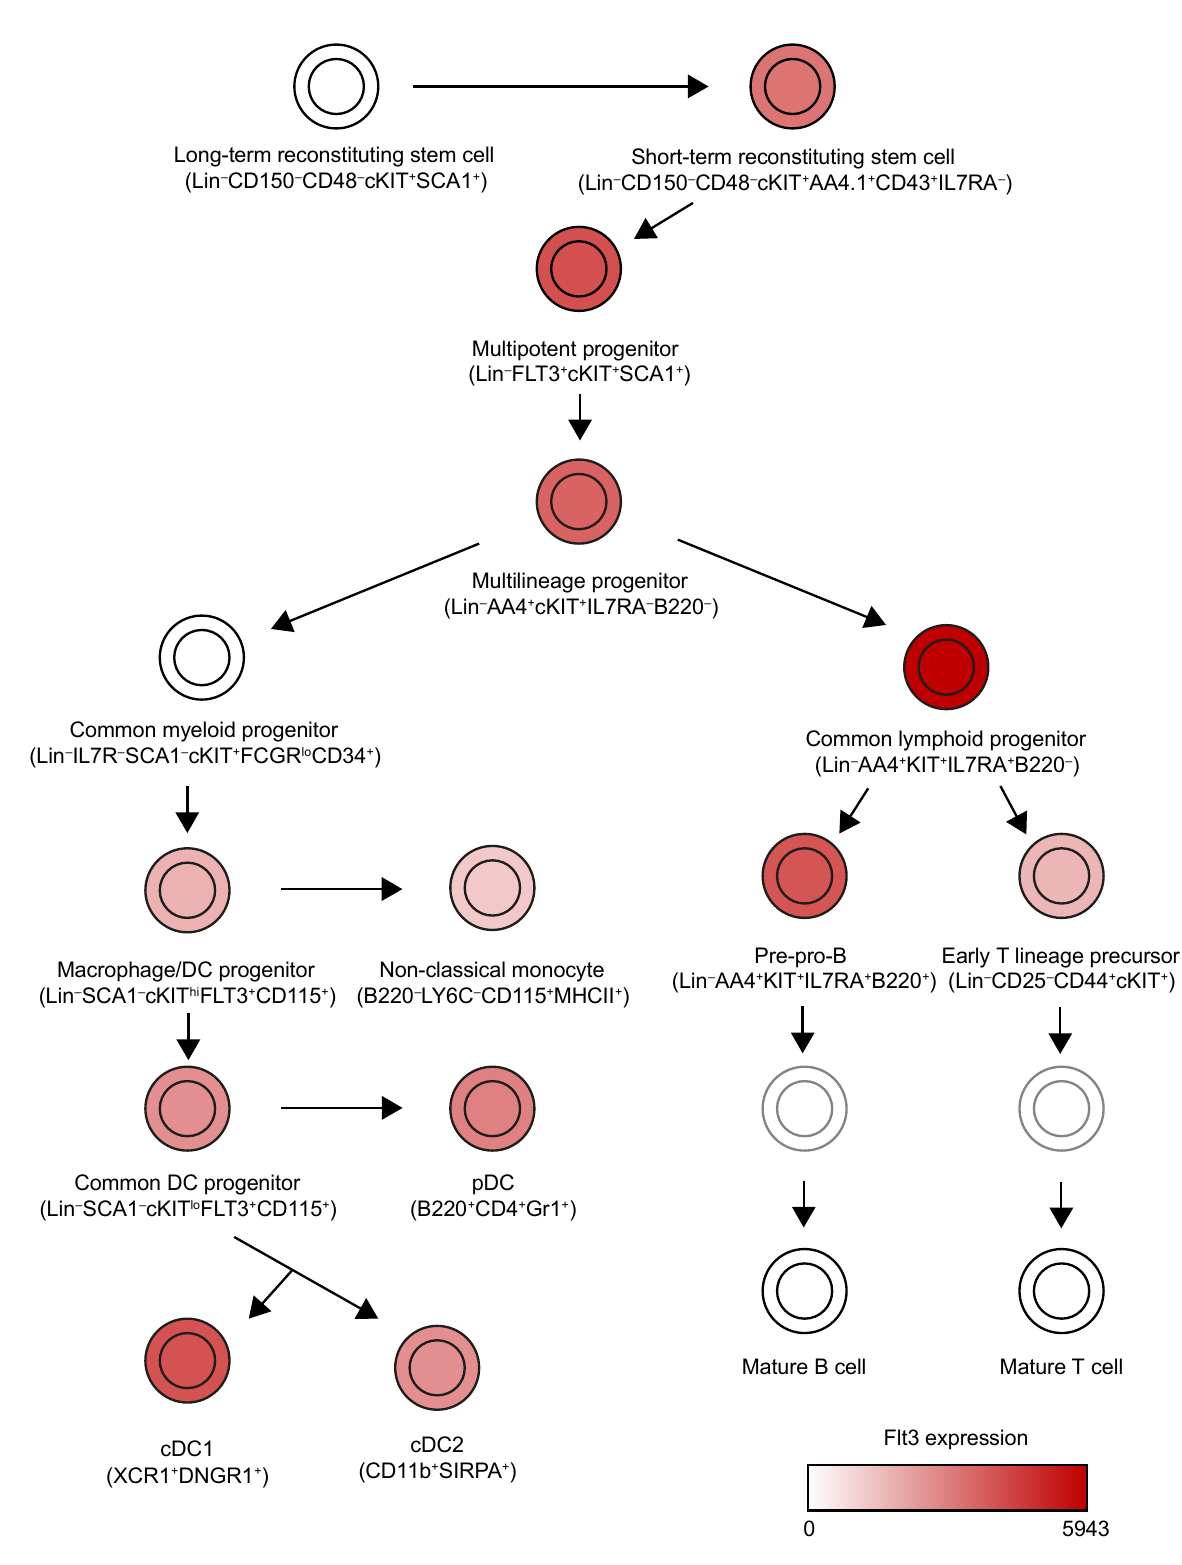
Figure 1. Expression pattern of Flt3 across mouse hematopoietic lineages. We have simplified the lineage tree generated by Jojic et al. [5]. This tree includes all cell populations identified by the first project of ImmGen to express high levels of Flt3 (relative expression > 1000). In the case of mature cDC1s, cDC2s and pDCs, an average of Flt3 expression has been used to color them, because different populations from different organs were characterized in this consortium.